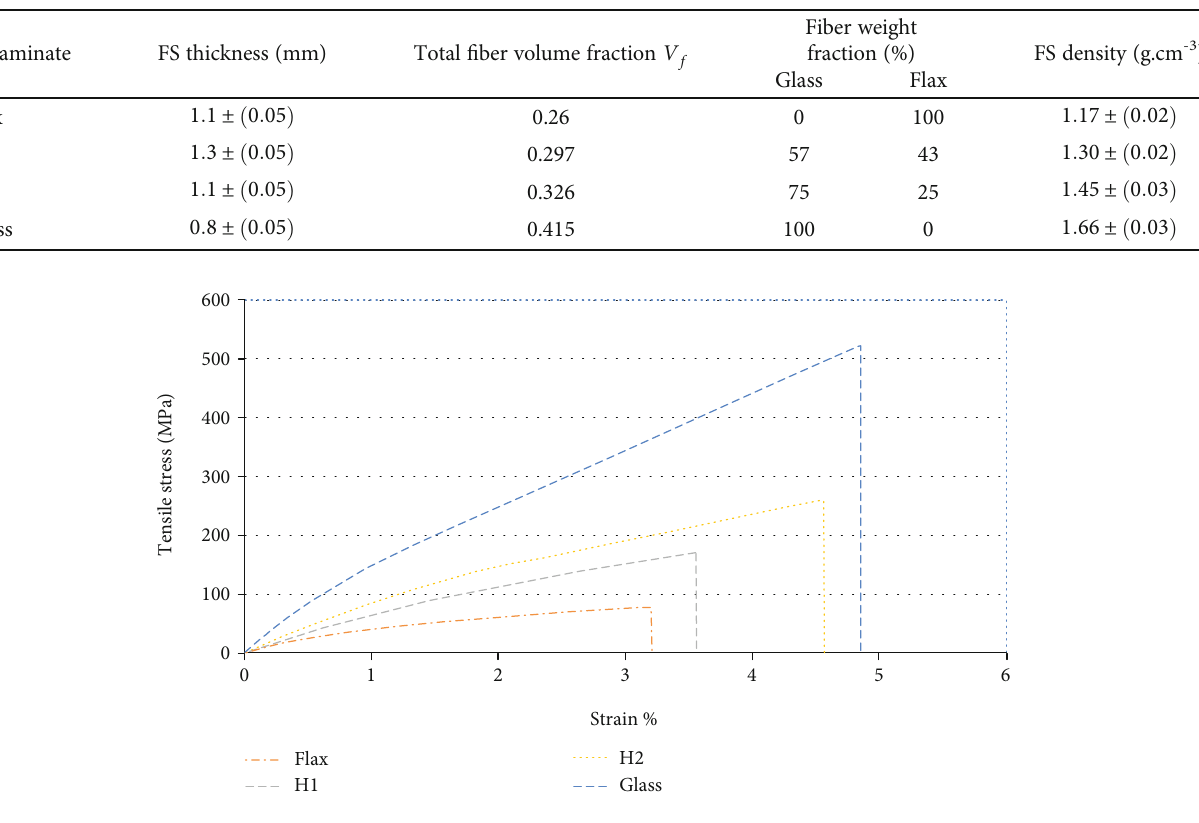
Figure 7: Stress-strain curves of tensile loading. Table 3: Tensile force, strength, and modulus of the composite laminates.